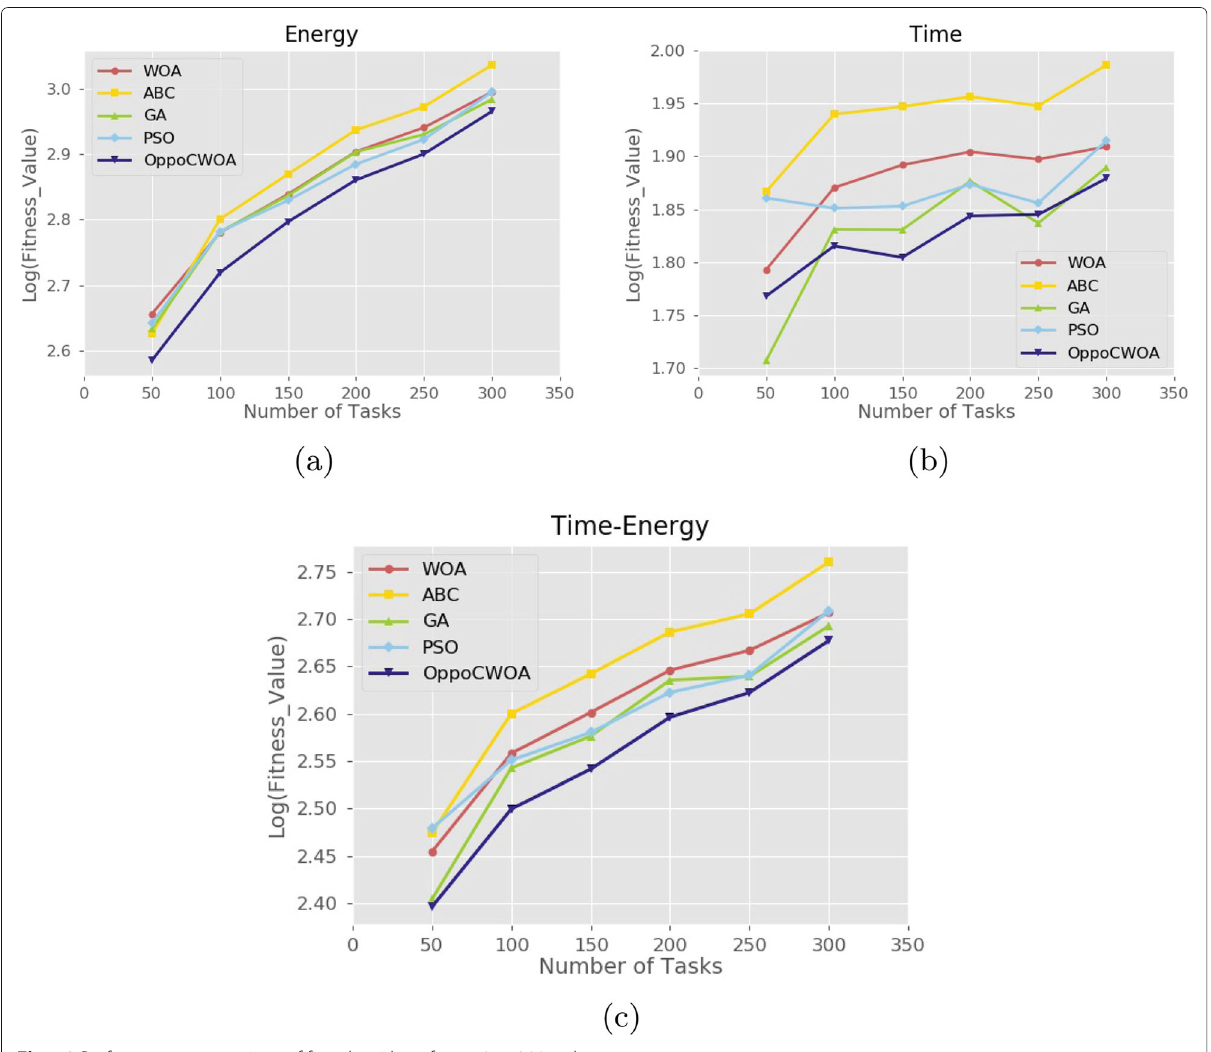
Fig. 13 Performance comparison of five algorithms from 50 to 300 tasks